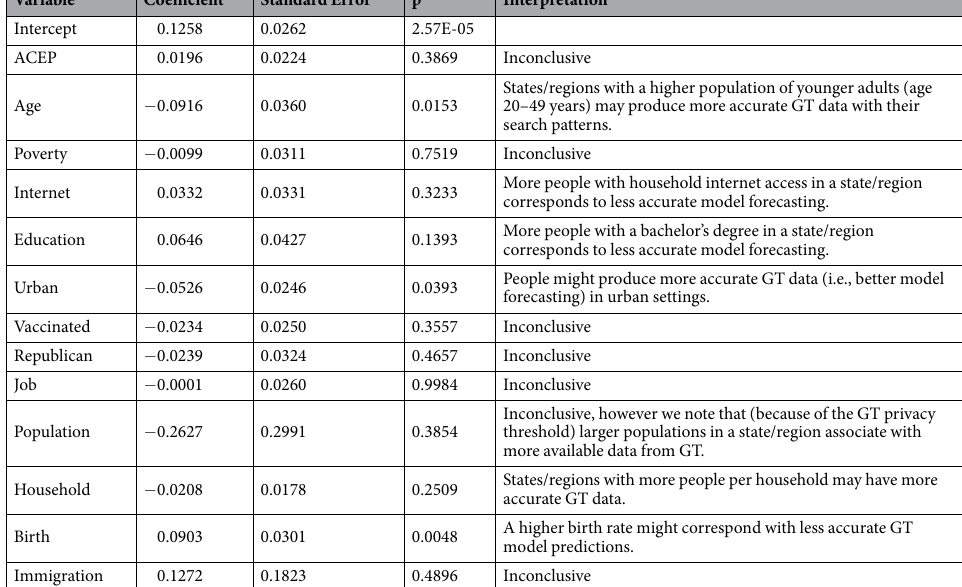
Table 4. Summary of coefficients, standard error, p values and a brief interpretation of each variable’s effect on the 52-week forecast RMSE in the exploratory sociodemographic model (see Table 2 for definitions of variables). Interpretations were deemed inconclusive if the standard error was larger than the magnitude of the coefficient – otherwise the interpretation explains the coefficient’s directionality (how an increase in the variable relates to the forecasting RMSE). Abbreviations: GT: Google Trends. See Table 2 for variable